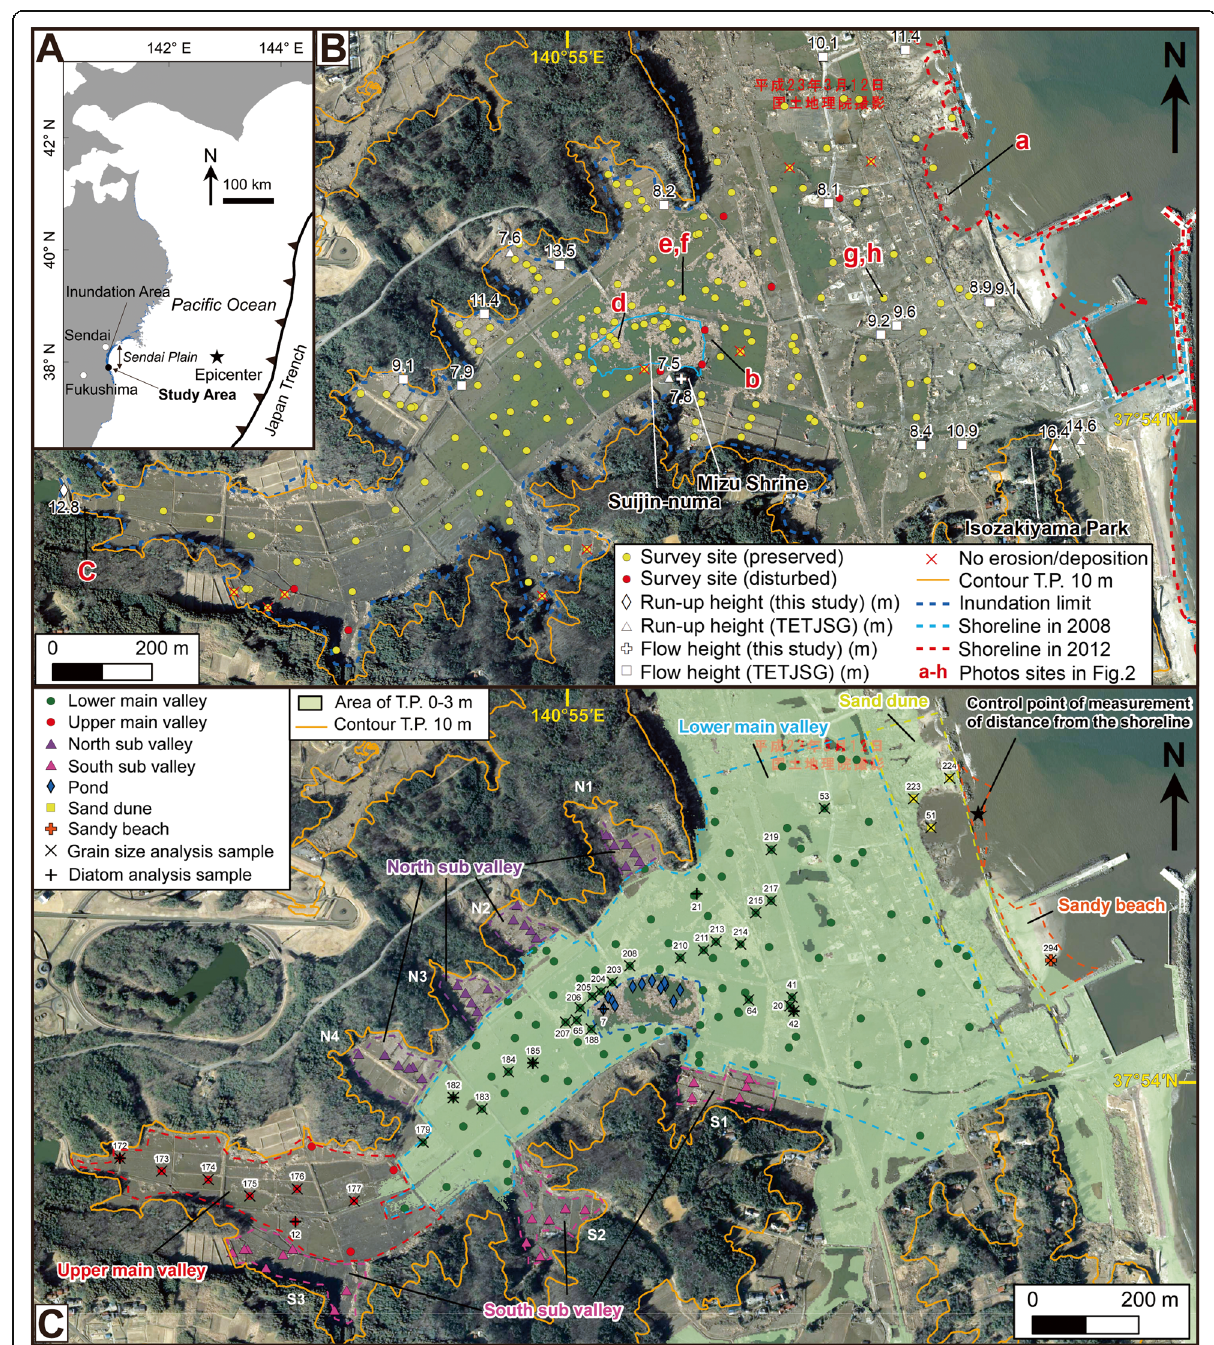
Fig. 1 Maps showing a the location of study area; b survey site, run-up height, flow height, inundation limit, and location of photograph sites in Fig. 2; and c topographic type and sampling site for analysis. a The inundation area of the 2011 tsunami is based on data provided by the Geospatial Information Authority of Japan (GSI). b , c The aerial photographs taken on the day after the tsunami (March 12, 2011) and the shoreline location were provided by GSI. Inundation limit, run-up height, and flow height were measured for this study and by the 2011 Tohoku Earthquake Tsunami Joint Survey Group (TETJSG). c The contour line is based on the 2 m grid digital elevation model (DEM) data after the tsunami provided by GSI. No erosion/deposition means that no erosion of pre-existing sediments or no deposition caused by the 2011